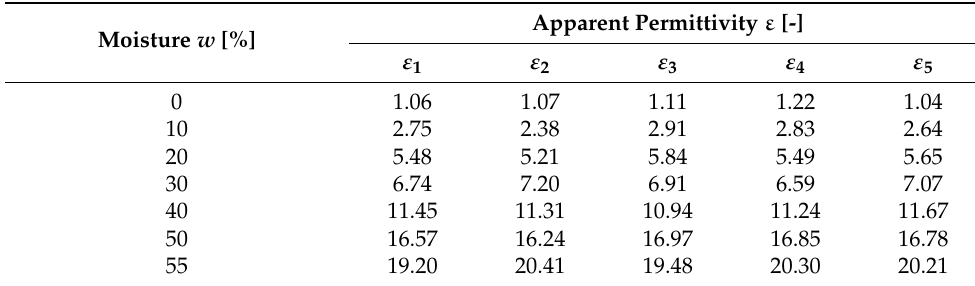
Table 4. Results of the apparent permittivity ε measurements with the FP/mts invasive probe for different values of moisture w; 600 c.c.